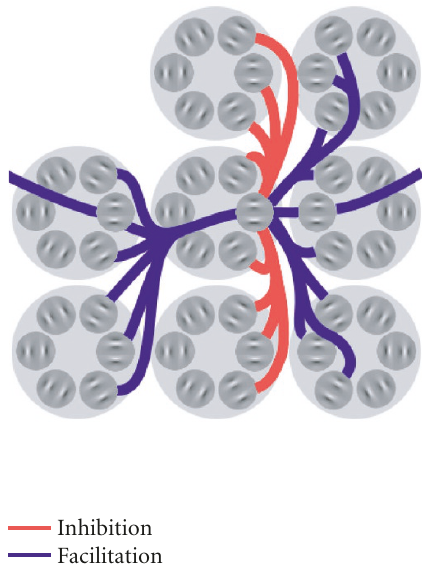
Figure 2: Schematic structure of the primary visual cortex im- plemented in the present study. Simple cortical cells are mod- eled through log-Gabor functions. They are organized in pairs in quadrature of phase (dark-gray circles). For each position the set of di ff erent orientations compose a pinwheel (large light-gray cir- cles). The retinotopic organization induces that adjacent spatial po- sitions are arranged in adjacent pinwheels. Inhibition interactions occur towards the closest adjacent positions which are in the direc- tions perpendicular to the cell preferred orientation and toward ad- jacent orientations (light-red connections). Facilitation occurs to- wards coaligned cells up to a larger distance (dark-blue connec-